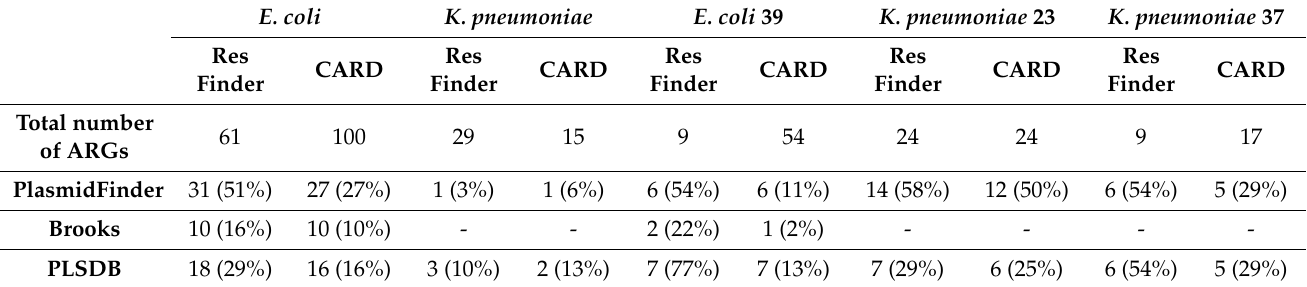
Table 5. Number of total identified ARGs and ARG Plasmid (sharing the same contig with P TRUE from three different databases), using ResFinder and CARD databases in both E. coli and K. pneumoniae and hybrid assembled isolates. The number inside parentheses shows the percentage of ARG Plasmid identified in P TRUE from different plasmid databases. E. coli 39, K. pneumoniae 23, and K. pneumoniae 37 are hybrid assembled isolates.